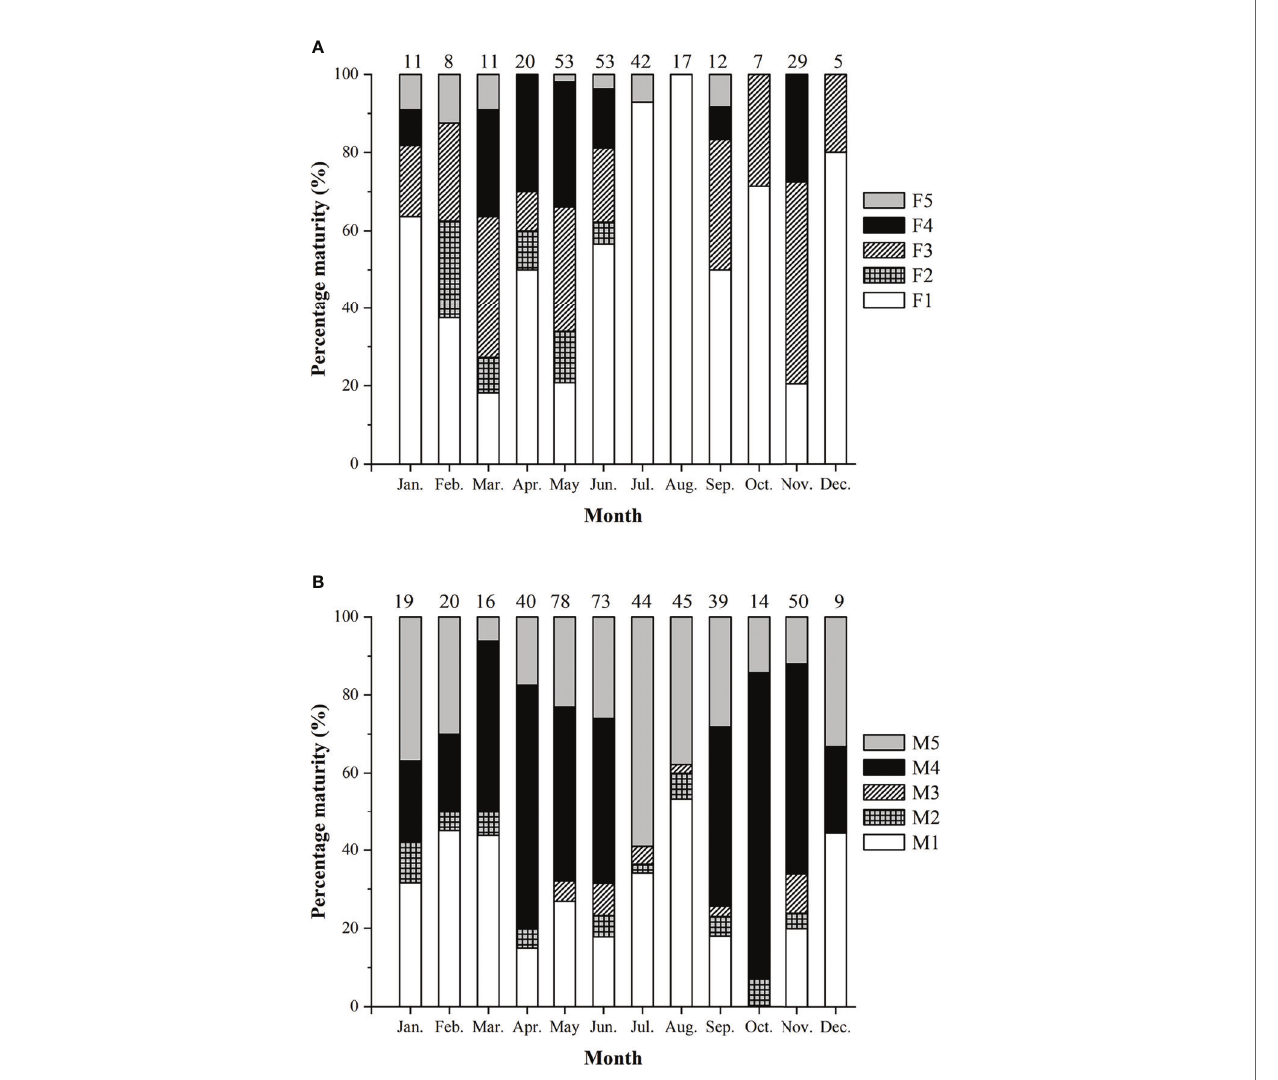
FIGURE 7 | Percentage of sexual maturity stages of Larimichthys crocea. (A) Female. (B) Male. F1/M1: immature/resting; F2/M2: developing; F3/M3: maturing; F4/ M4: ripe; F5/M5: spent. Numbers above the bars referred to the sample